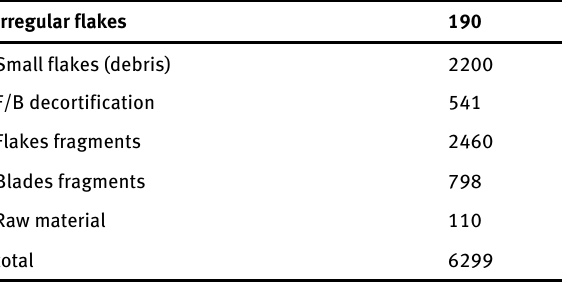
Figure 5. Lipari, Contrada Diana trench XVII. Histogram 3: synthesis of obsidian artifacts. Table 1. Lipari, Contrada Diana trench XVII. Products of the second stage of